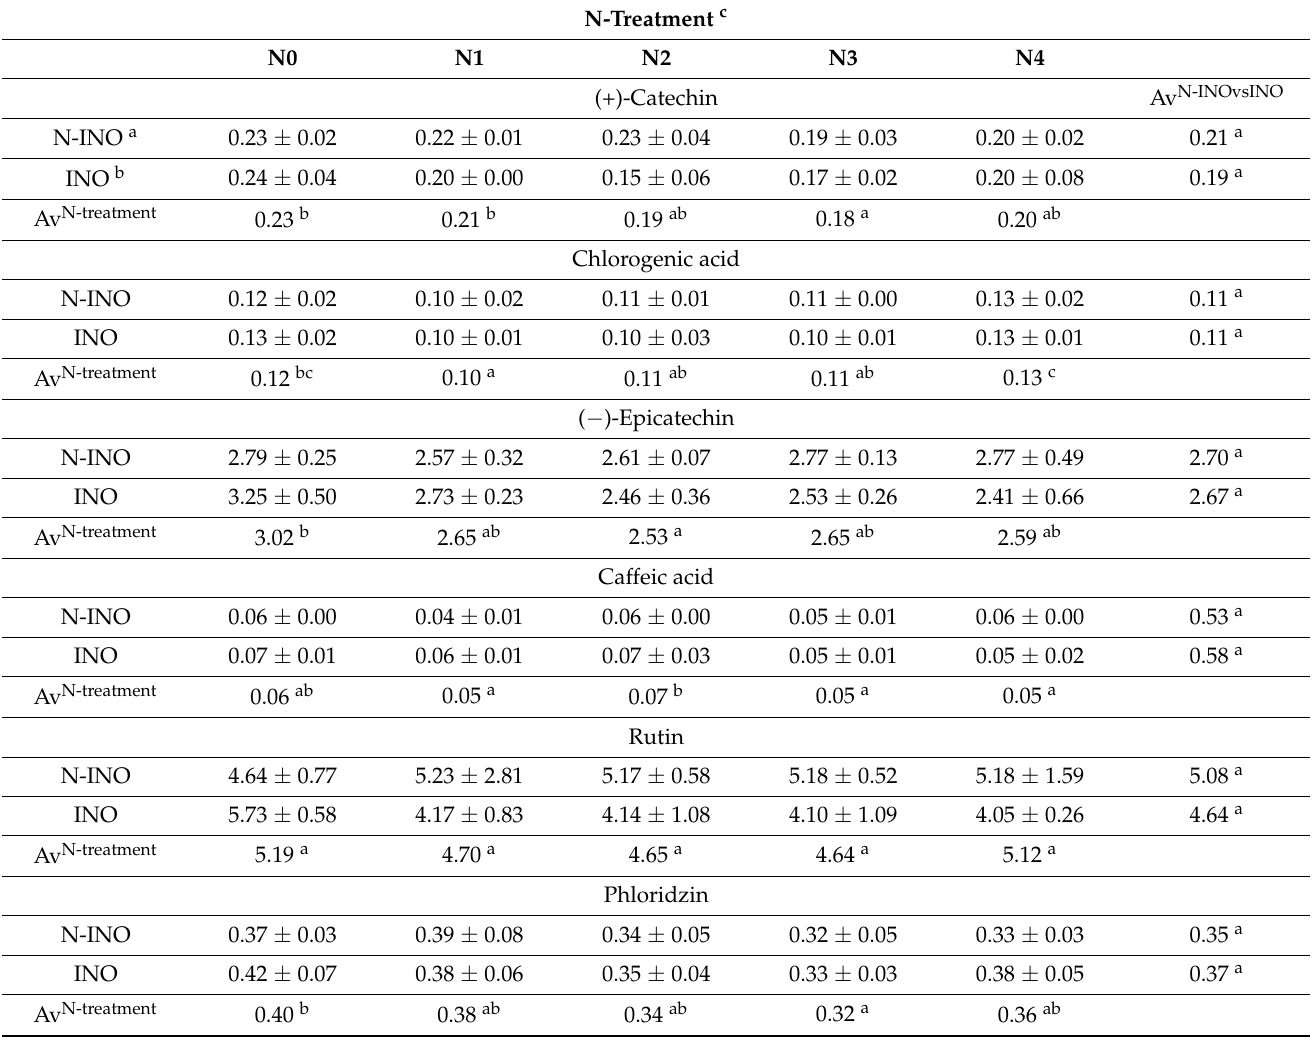
Table 3. Individual phenolic compound concentration depending on N-dose and its way of applica- tion in inoculated and non-inoculated plants (g kg − 1 DW). N-Treatment